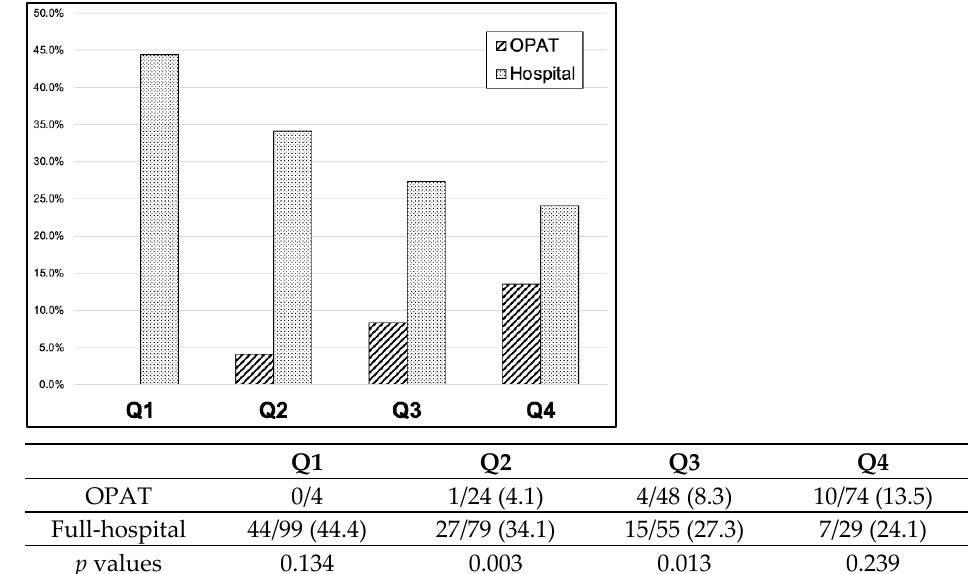
Table 3. Multivariate logistic regression analysis for OPAT program on 60-day treatment failure.